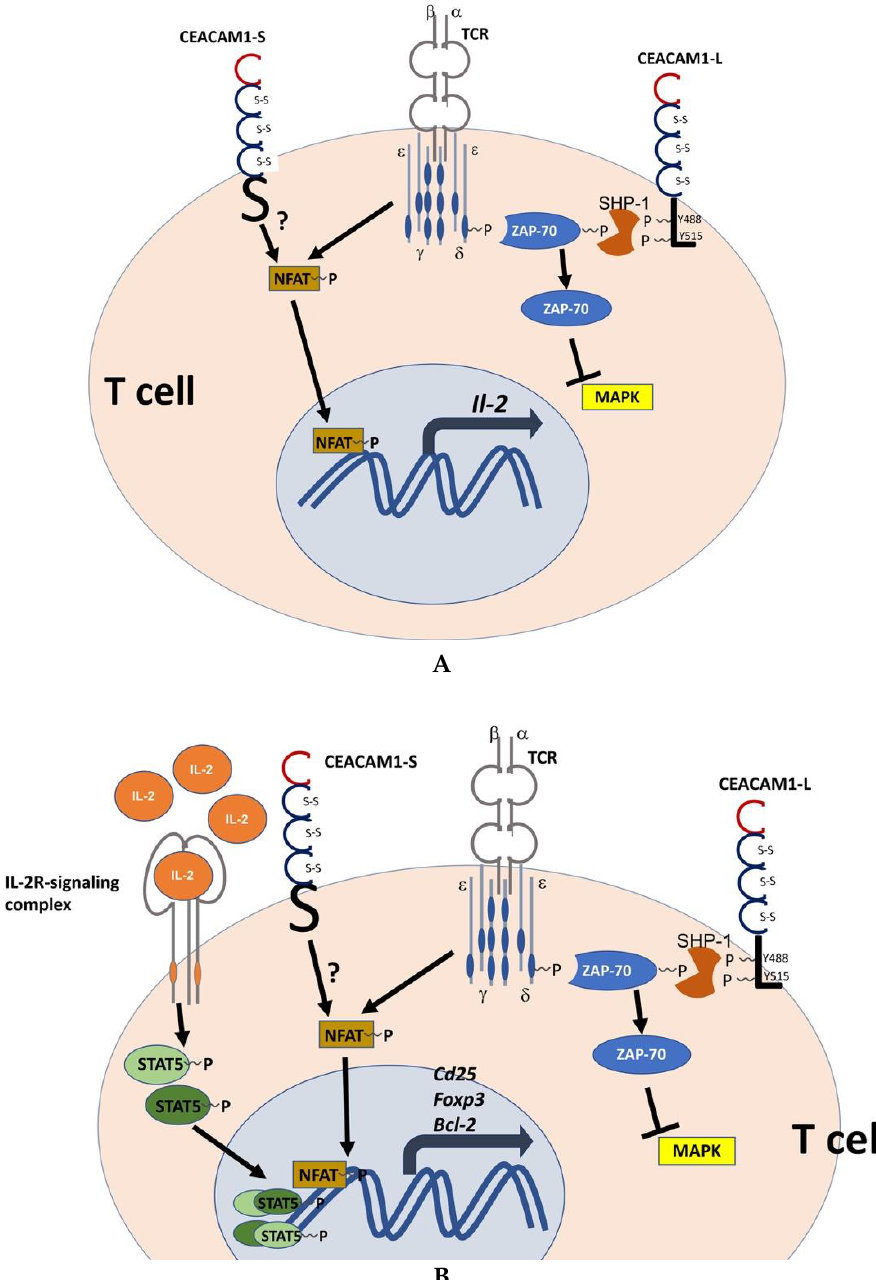
Figure 5. Specific functions of CEACAM1-S and CEACAM1-L isoforms in the regulation of T cell activation. ( A ) Different features of the CEACAM1-isoforms, CEACAM1-S and CEACAM1-L, in T cell signaling: CEACAM1-S and the TCR complex trigger T cell activation, and NFAT-mediated signaling [176,231]. Subsequently, NFAT nuclear translocation and transcription of Il-2 are initiated; CEACAM1-S can act as an independent signaling unit in T cells. CEACAM1-L with two ITIM motifs is phosphorylated by Src family kinases, and subsequently binds SHP-1 that dephosphorylates ZAP-70 and consequently blocks TCR-mediated activation of MAPK signaling in T cells [5,177,178]. The molecular adaptors that relay CEACAM1-S signaling via NFAT1 have not been defined yet. The initiation of CEACAM1-S-mediated IL-2 production is a key event in Treg induction and stability ( B ). Upon CEACAM1-S and TCR-induced IL-2 production, signaling of the IL-2R complex induces STAT5 phosphorylation; phosphorylated STAT5 translocates into the nucleus and acts as a transcription factor in a heterodimeric or heterotetrameric complex. pSTAT5 controls the transcription of key functional Treg genes, such as CD25 , Foxp3 , and Bcl-2 , indicated by a curved black arrow ([204], and